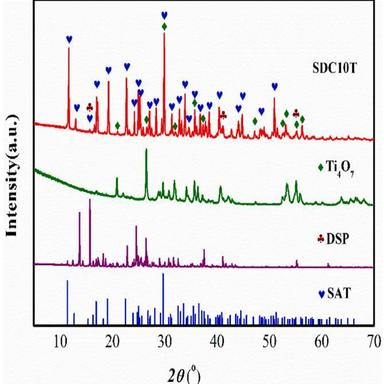
The XRD patterns (a) of SDC10T, Ti4O7, DSP and SAT.